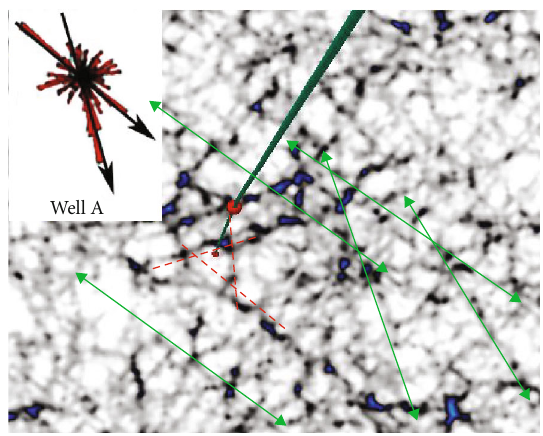
Figure 11: Prediction map of Well A of the fracture azimuth predicted result compared with imaging log.